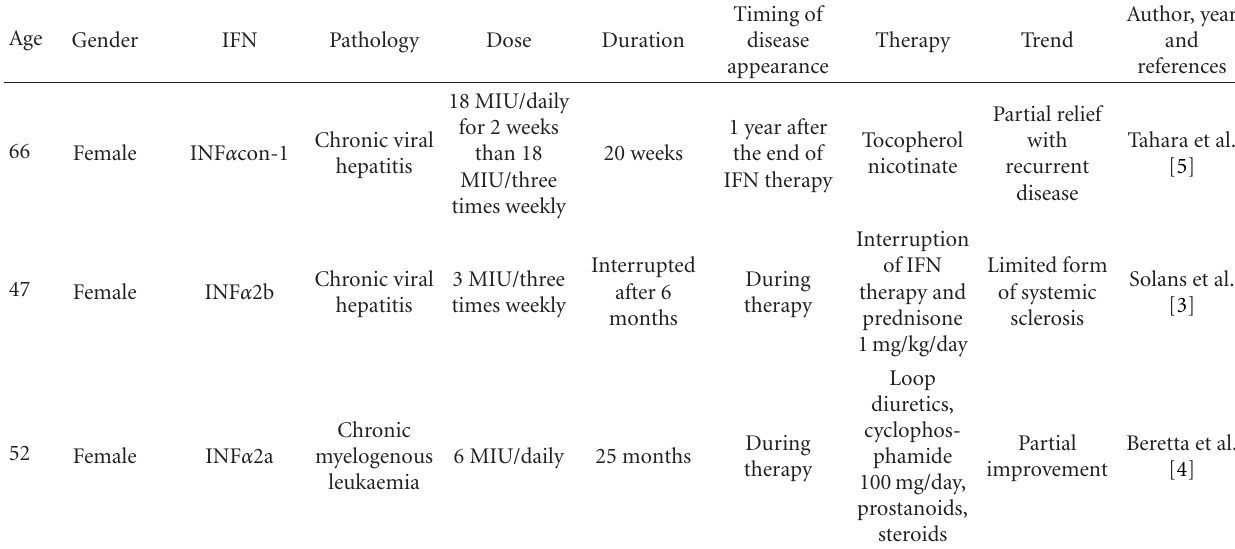
Table 3: Case reports from